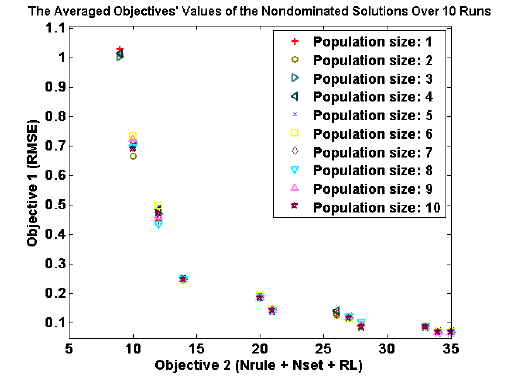
Fig. 11. The averaged Pareto fronts found in 10 independent runs with different initial population sizes.